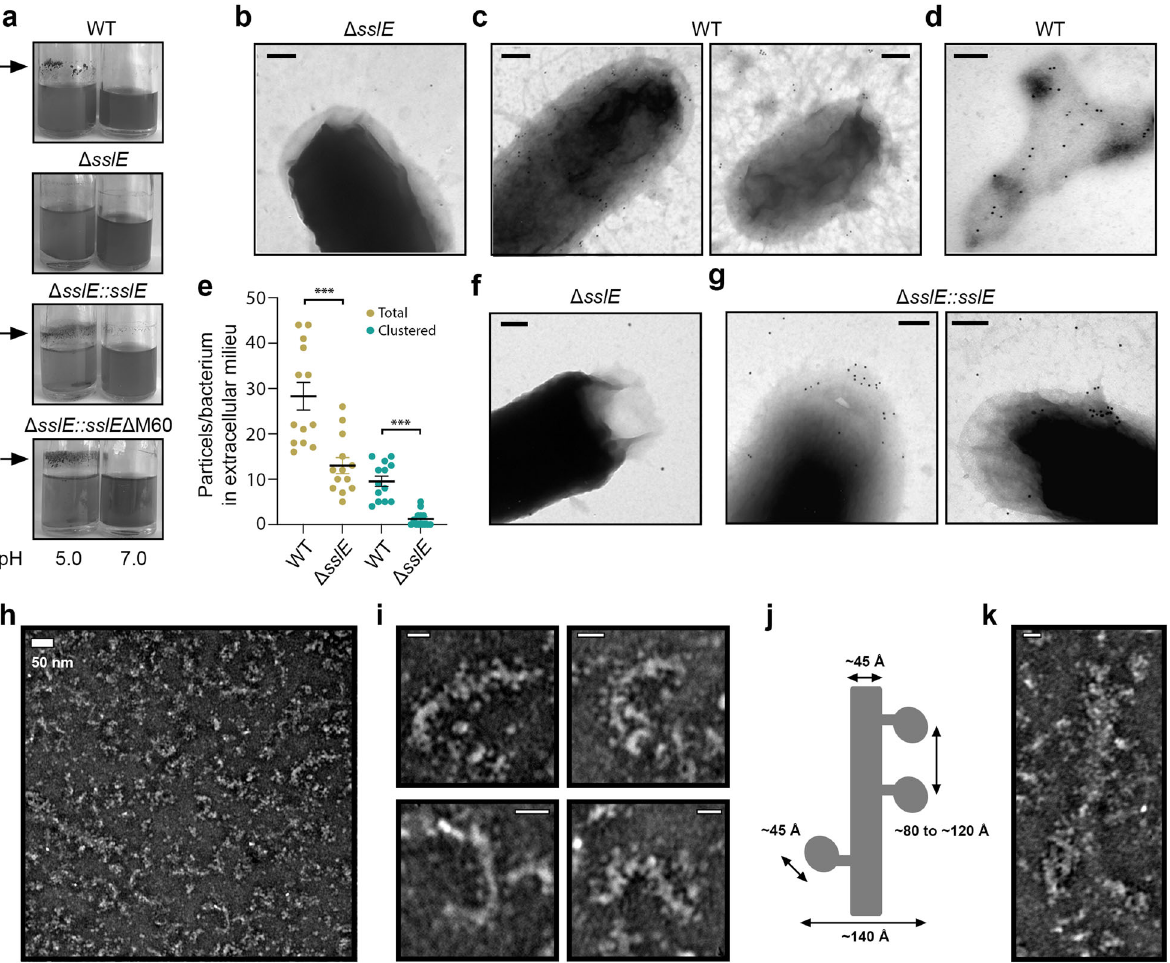
Fig. 3 TEM analysis of E. coli W SslE aggregations. a Accumulation of SslE aggregates on the side of glass tubes containing overnight cultures grown in LB media at pH 5.0 or 7.0. Arrows indicate Congo red-stained ring containing SslE. b – g SslE localisation upon secretion from E. coli W strains assessed by immunoelectron microscopy. Bacteria were reacted with primary α -rSslE antibodies and secondary gold-labelled antibodies on carbon-coated nickel grids and then negatively stained with uranyl acetate. b , f E. coli W Δ sslE mutant washed in citrate- phosphate buffer at pH 5.0 or 4.0, respectively. c Wild-type W strain washed in citrate-phosphate buffer at pH 5.0 with α -rSslE antibodies reacting with the bacterial surface and secreted fi brous material. d Image highlighting clustering of antibodies to an extracellular aggregate. e Analysis of total and clustered ( ≤ 25 nm between particles) α -rSslE antibodies reacting with aggregates in the extracellular milieu of wild-type and Δ sslE mutant bacteria at pH 5.0. *** P < 0.001; verses Δ sslE mutant by two-tailed Student ’ s test and error bars are the standard error of the mean. g Δ sslE::sslE W strain washed in citrate-phosphate buffer at pH 4.0, again with α -rSslE antibodies reacting with the bacterial surface and secreted fi brous material. Scale bar is equivalent to 200 nm. h TEM analysis of negatively stained rSslE aggregates. Two major species are observed. i Smaller fi laments have an average width of ∼ 4.5 nm and are coated with globular structures of ~4.5 nm in diameter. Scale bar, 20 nm. j Schematic describing the overall dimensions of the smaller SslE fi bre species. k Larger species of SslE aggregates appear as ~20 – 40 nm wide structures with variable lengths. Scale bar, 20